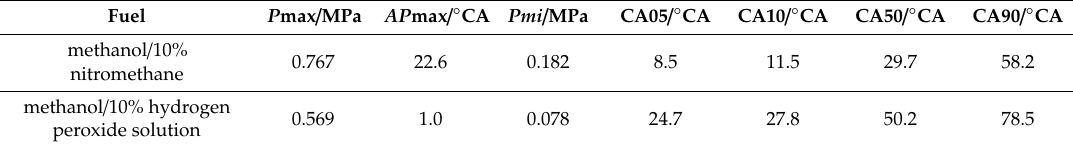
Table 4. Characteristic parameters of methanol fuel with